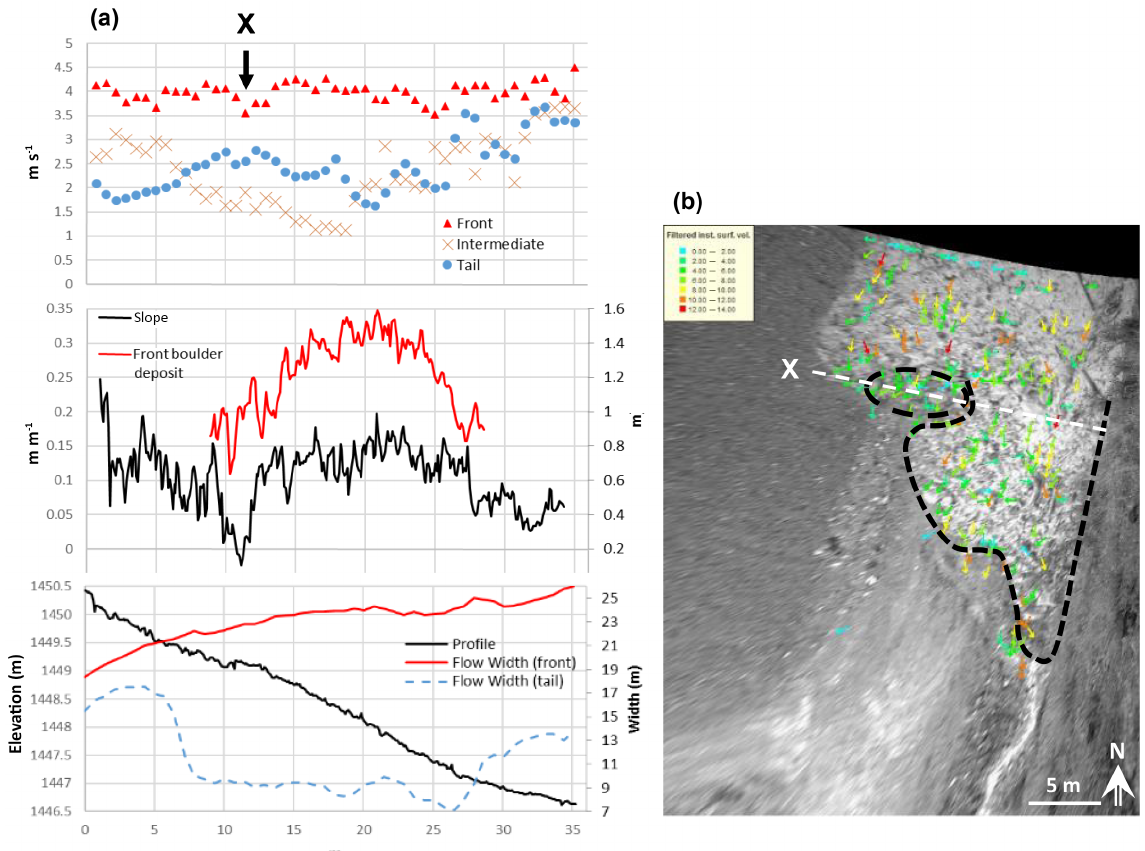
Figure 8. (a) The 2013 debris-flow LSPIV average velocity of the front (red), intermediate (yellow), and tail (blue) travelling down the long profile of the grid in Fig. 7. Local slope and the boulder front deposit (from multi-date SfM) are also plotted along the distance (centre) as well as pre-event elevation and flow width of both the front and tail (bottom). At the cross section X, the boulder front is seen to deposit, while the watery surge passes around it (b) , which gives constant peak velocity at the front of the surge (despite the front